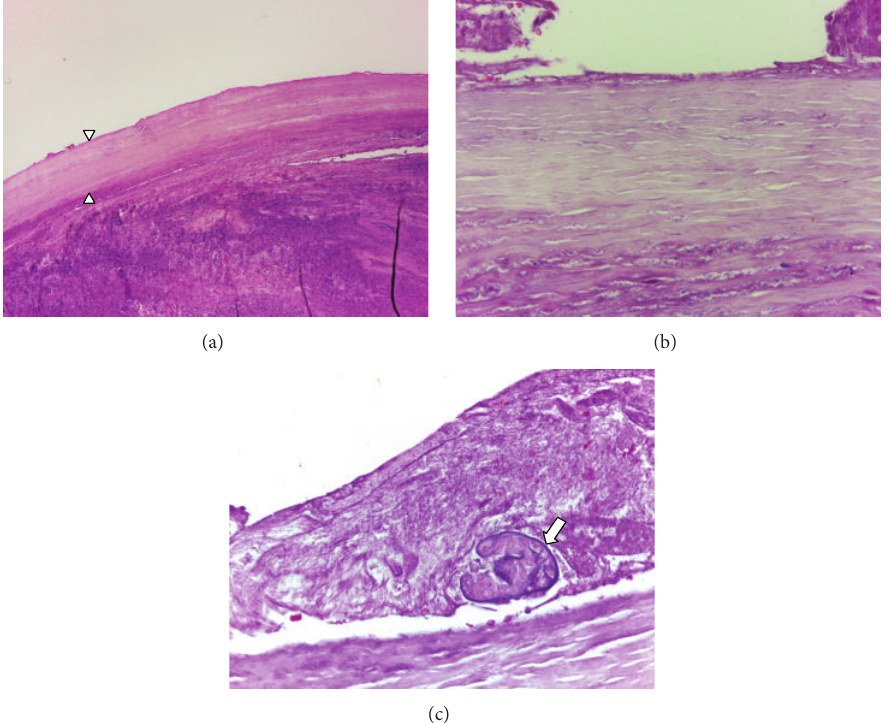
Figure 3: Pathologic examination: (a) acellular thick fibrous wall (arrowheads) (H&E stain, × 40); (b) the cyst wall revealing a characteristic lamellar pattern of the fibers (H&E stain, × 400); and (c) vestigial Protoscolex amidst membranous structures (arrow) (H&E stain, ×